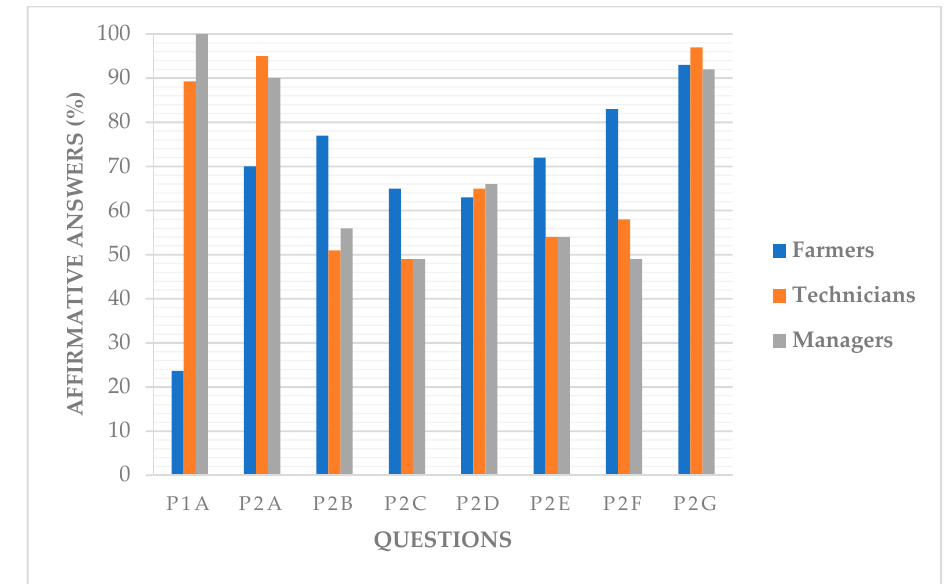
Figure 5. Answers for questions in Block 1 (all groups).